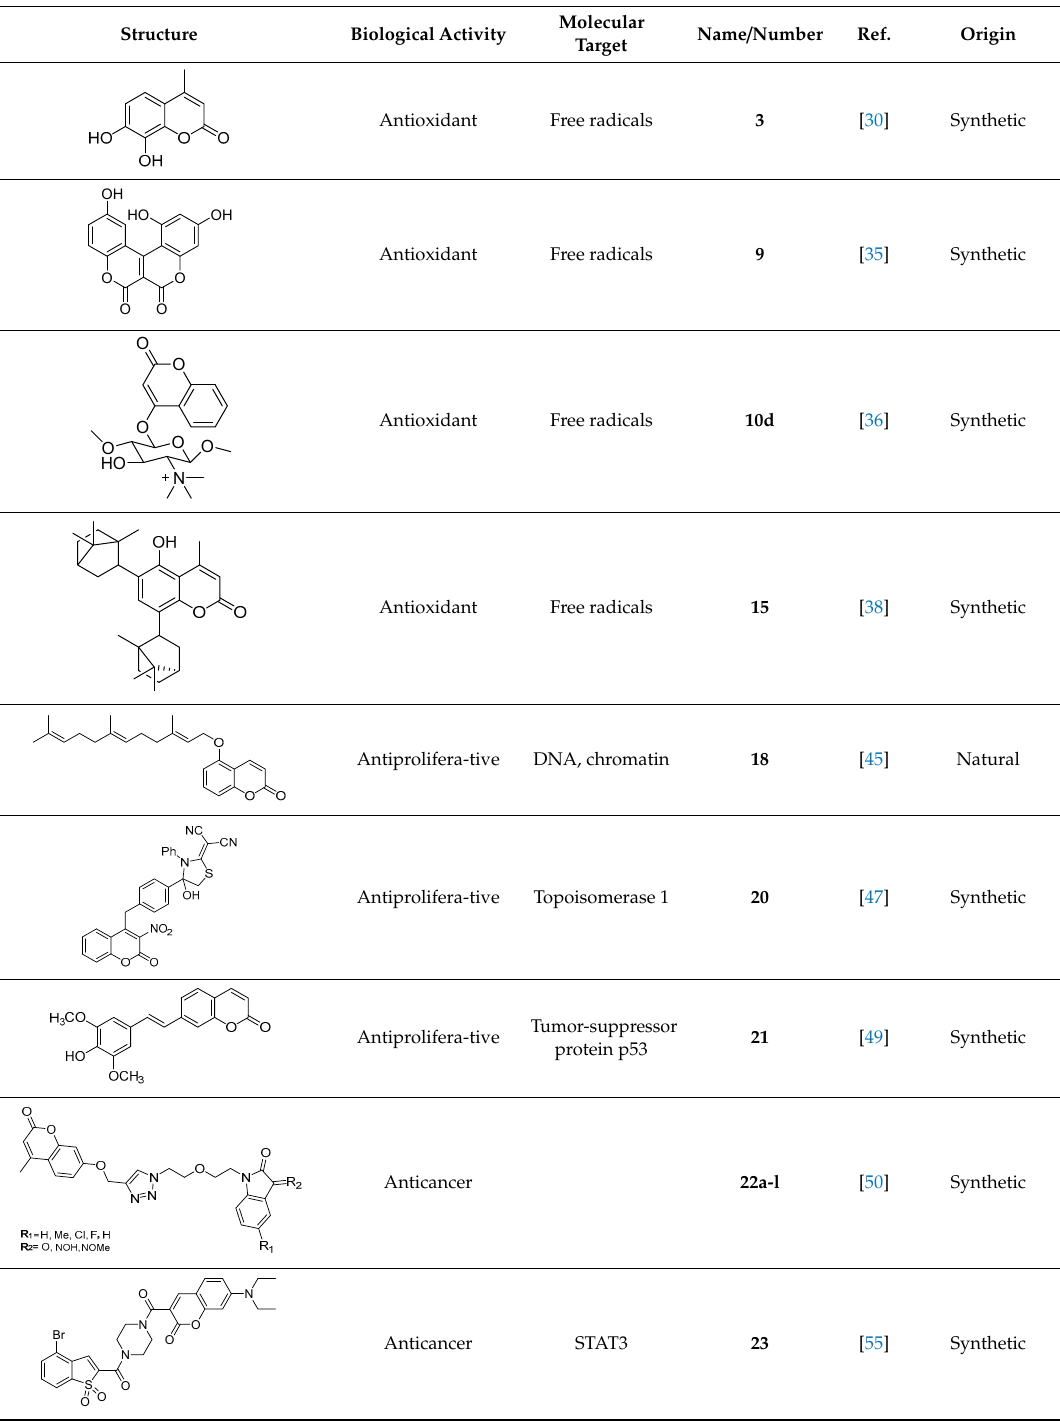
Table 2. Summary table.